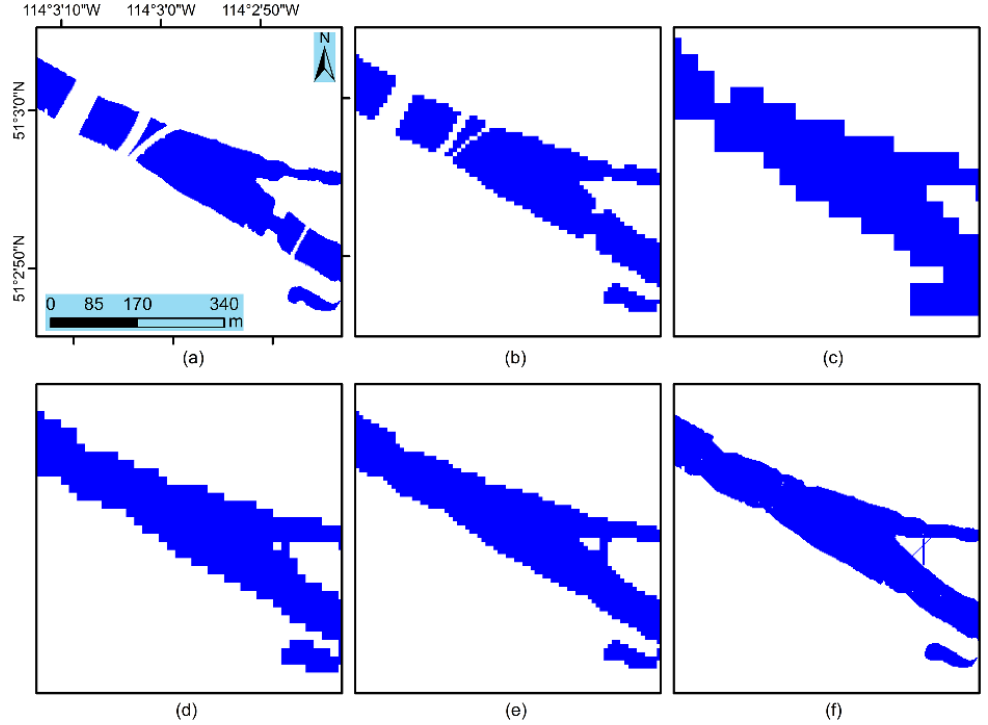
Figure 4. An example of image pyramid construction and topology transmission for river segments. ( a )–( c ) Image pyramid construction: images at level 0, 2, and 4 with pixel size